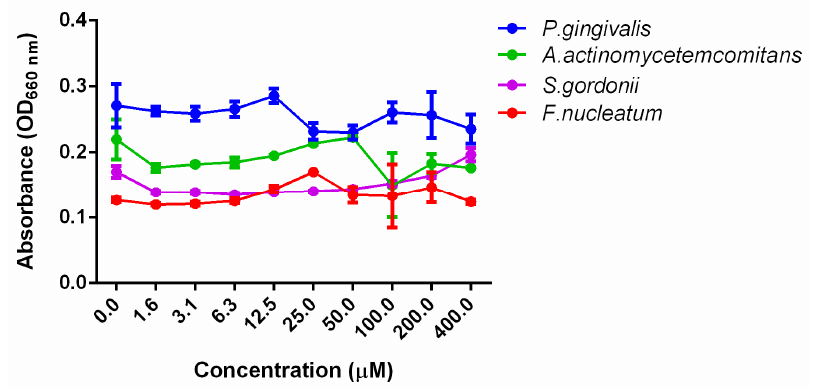
Figure 1. Effect of DMTU on planktonic cells. DMTU did not significantly inhibit bacterial growth up to 400 µM.